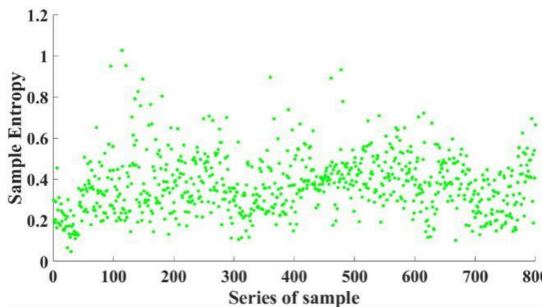
Figure 5. The sample entropy of 800